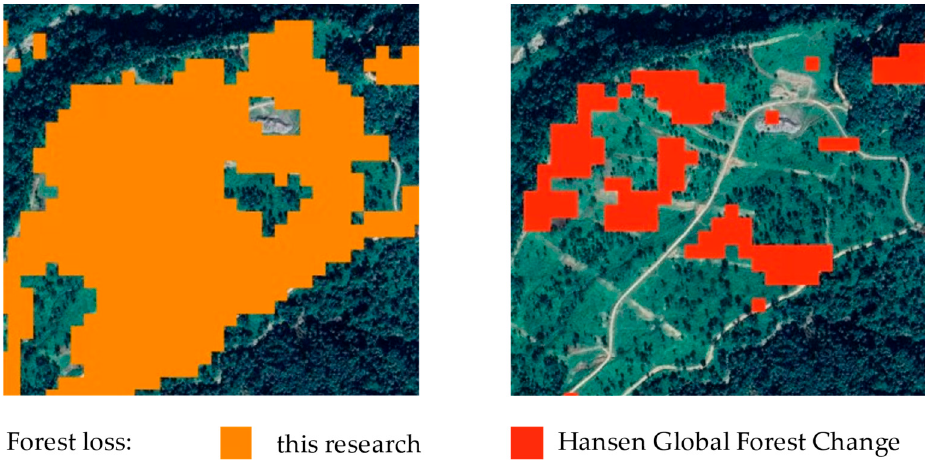
Figure 16. Comparison of forest loss dataset between this research and Hansen Global Forest Change [9].